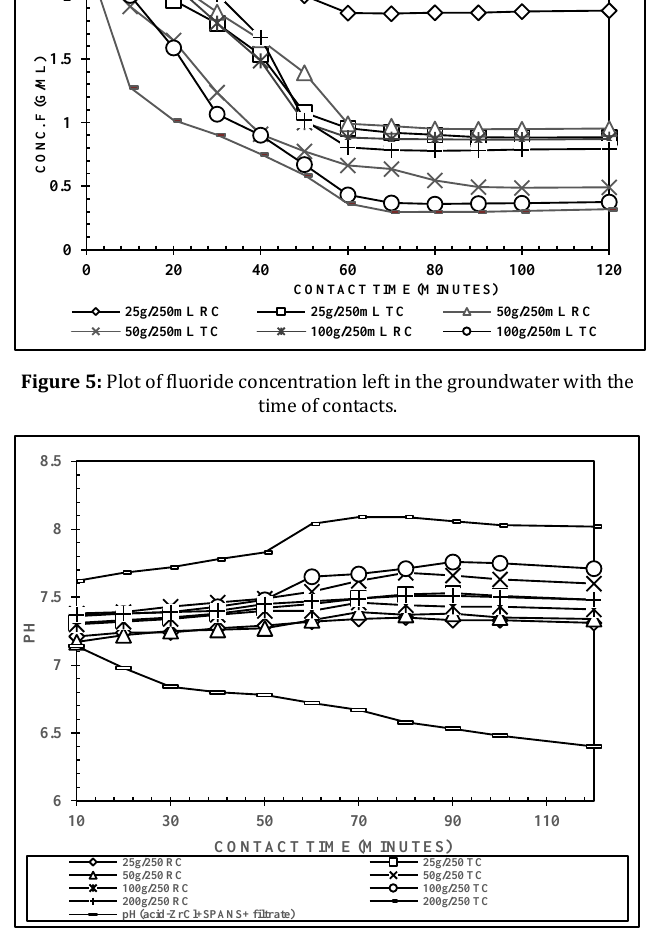
Figure 6: Plot of pH of the raw groundwater after various contact times with the clays.